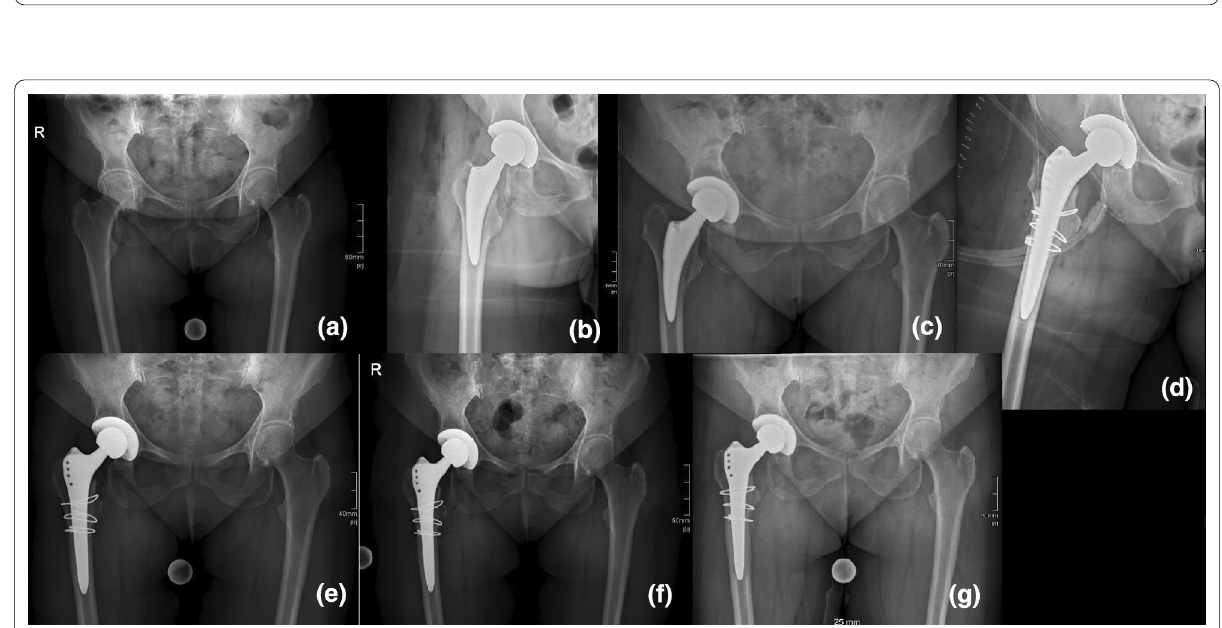
Fig. 1 Intraoperative fracture of the calcar treated with one cerclage wire: a preoperative; b postoperative; c 6 weeks postoperative; d 3 months postoperative; e 1 year postoperative